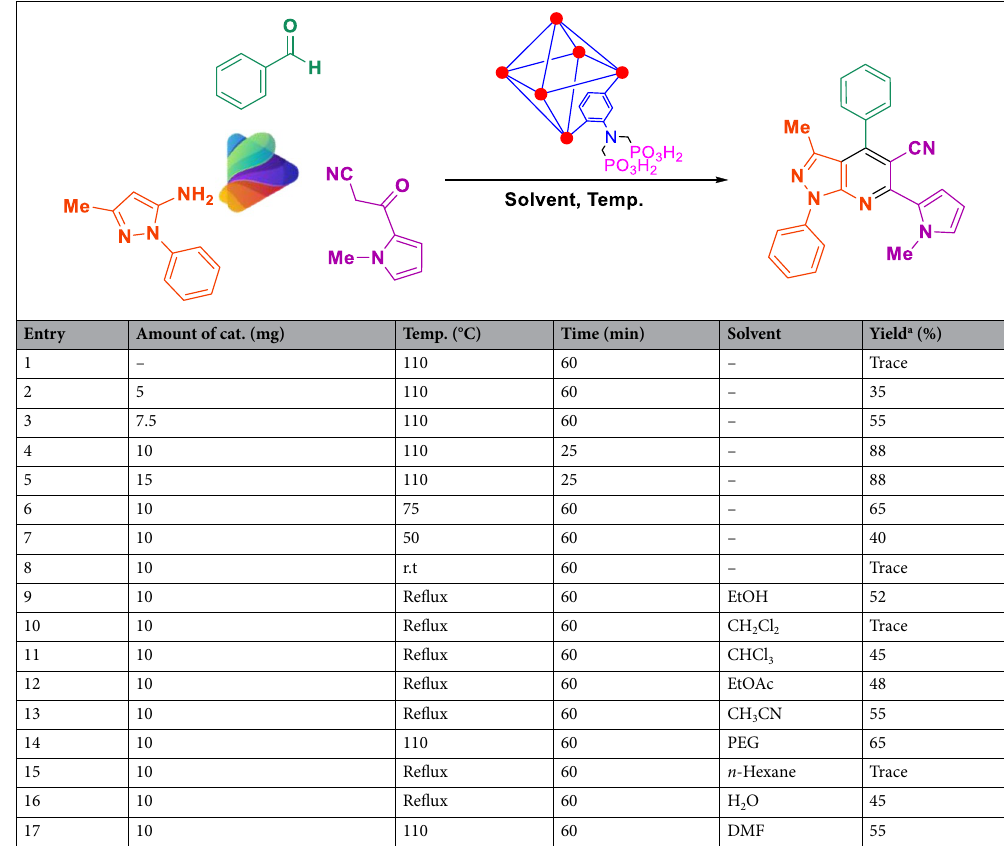
Table 1. Effect of different amounts of catalysts, temperature and solvent (5 mL) in the synthesis of ( N -methyl-pyrrol)-pyrazolo[3,4- b ]pyridines. a Reaction conditions: benzaldehyde (1.0 mmol, 0.106 g),